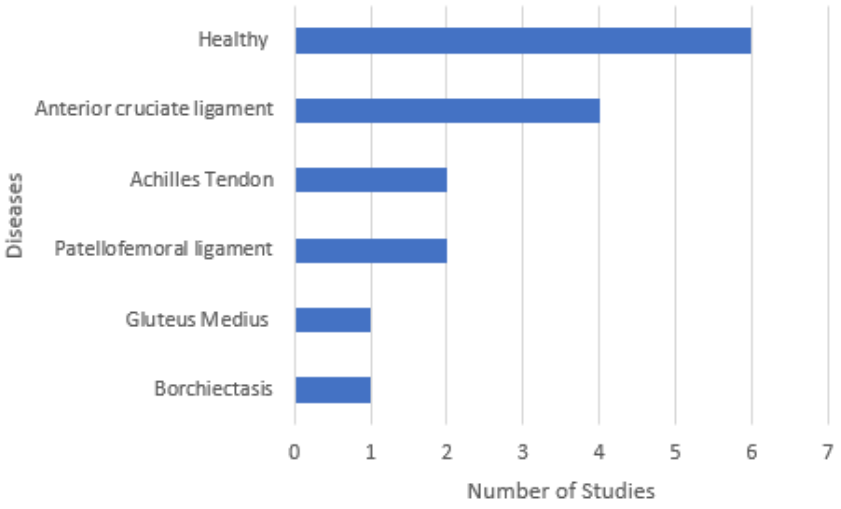
Figure 2. Distribution of the various diseases by the studies. Table 4. Relation between sensors used and its